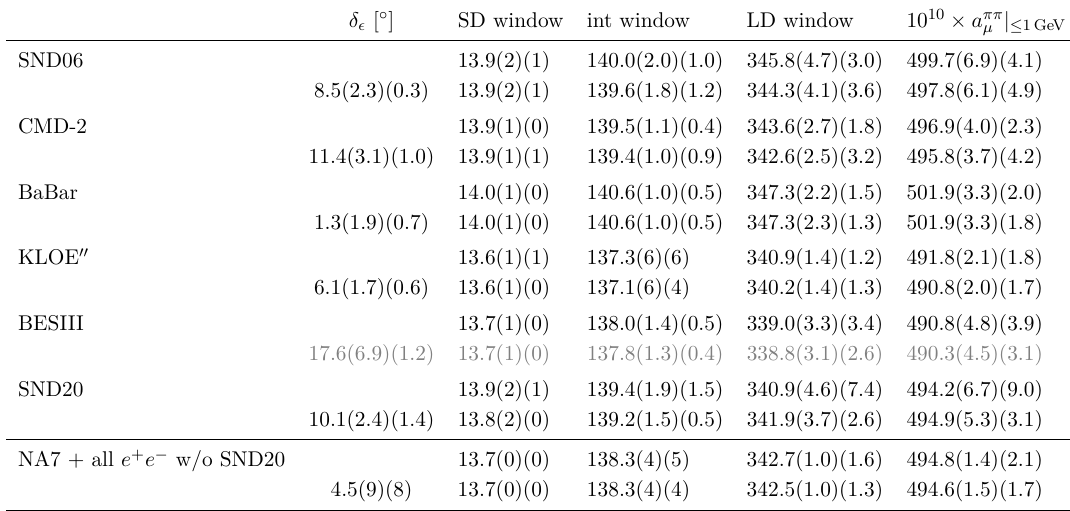
| ≤ 1 GeV into the Euclidean windows from ref. [36]. The first µ p χ 2 / dof , the second error is the combination of all systematic